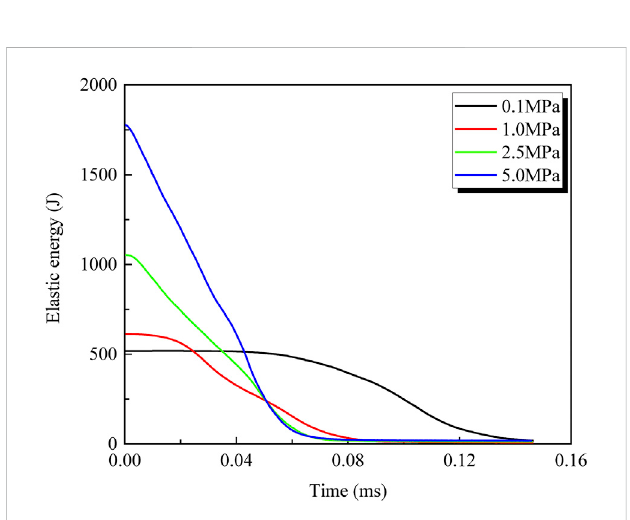
FIGURE 7 Change in elastic energy vs time for different pre-con fi ning